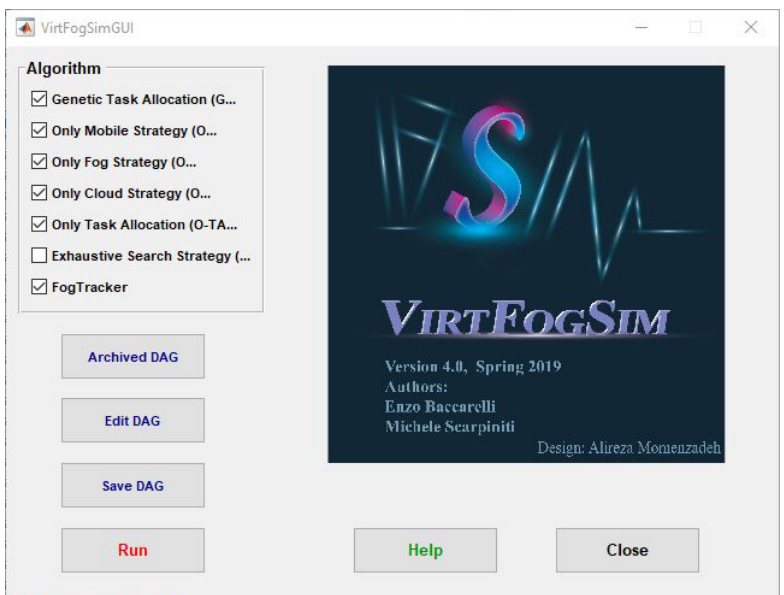
Figure A1. A screen-shoot of the GUI